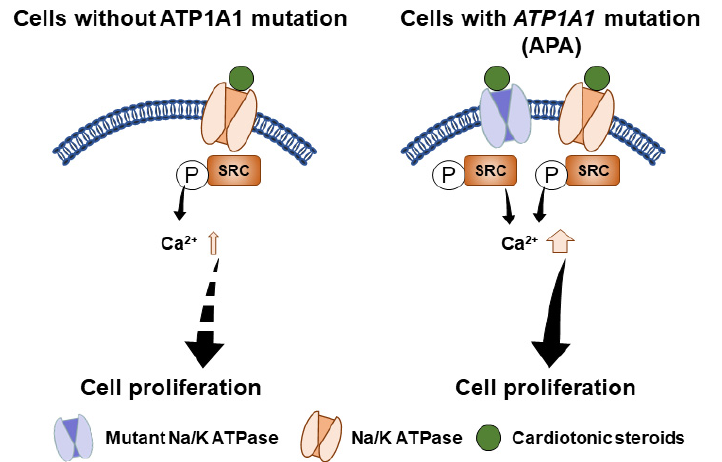
Figure 6. Hypothetical mechanism by which ATP1A1 mutations promote tumor progression. So- dium/potassium-transporting ATPase (NKA) are more highly expressed in aldosterone-producing adenomas (APA) with an ATP1A1 mutant to compensate for the loss of NKA pump function. This, subsequently, results in enhanced cell signaling function, including that of cell proliferation and intracellular Ca 2+ concentration, upon stimulation of NKA with very low levels of a cardiotonic ster- oid.